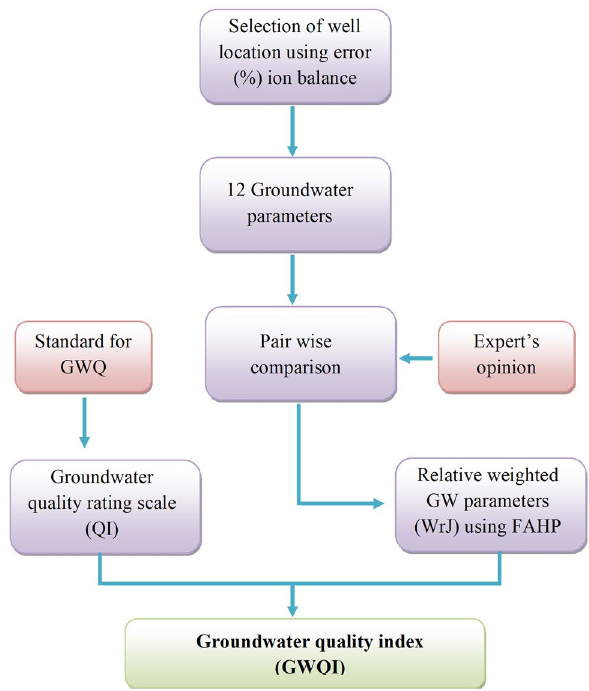
Fig. 2 Methodological